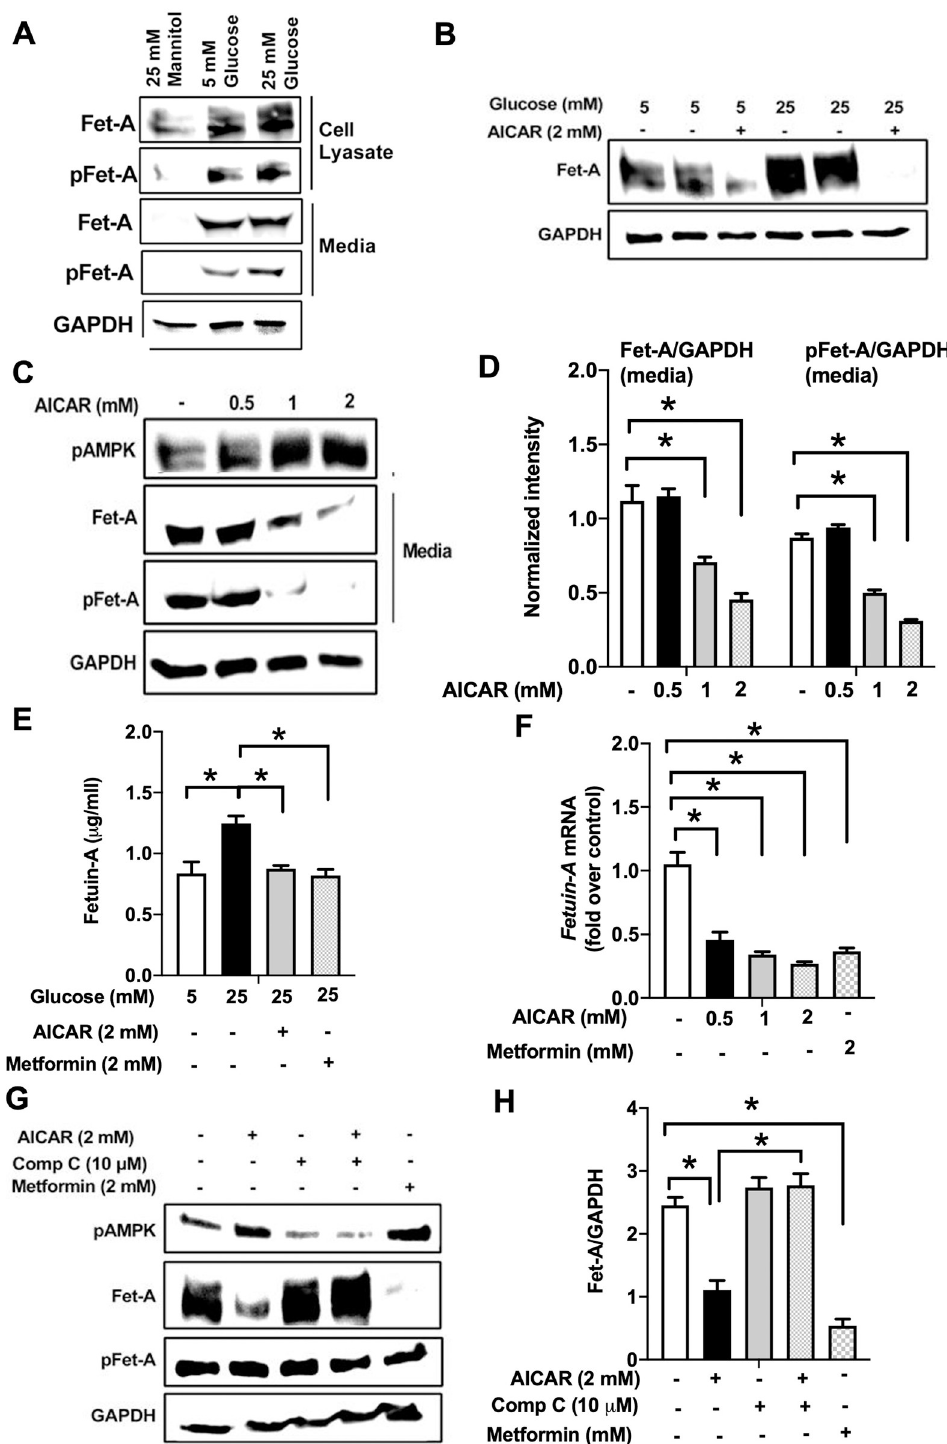
Fig 2. Activation of AMPK downregulates high glucose-induced Fet-A expression in HepG2 cells. [A] HepG2 cells were incubated in a media containing either mannitol, low glucose or high glucose for 12 hours, and cell lysates/media were subjected to immunoblotting for Fet-A and pFet-A (n = 3). [B] HepG2 cells were incubated with either low- or high-glucose in the absence or presence of AICAR for 12 h and cell lysates were analyzed by Western blotting. The blots were analyzed with antibodies against Fet-A (n = 4). [C] HepG2 cells were incubated with increasing